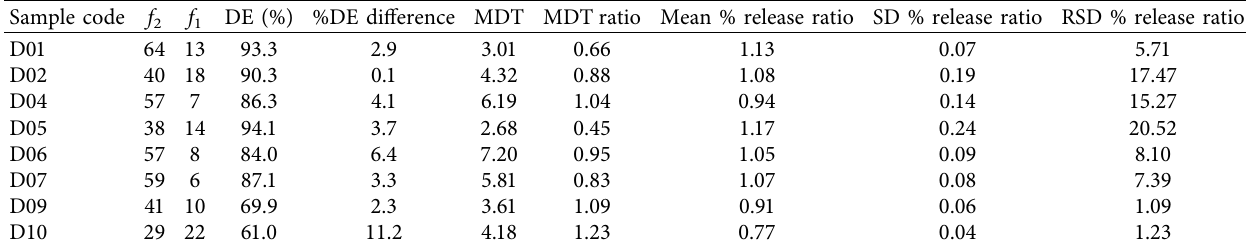
Table 3: Model-independent approaches results of doxycycline hyclate 100mg brands. Sample code f